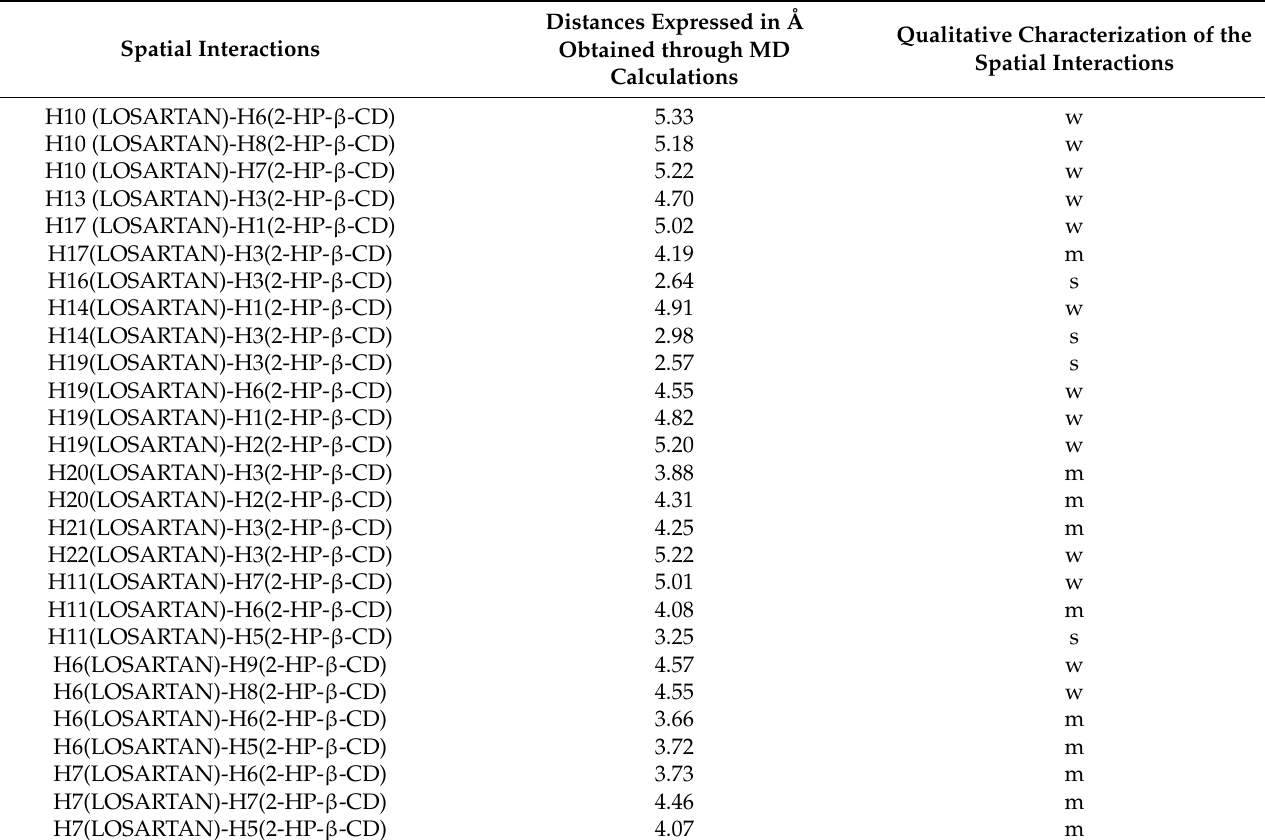
Table 3. The most important comparative distances in the complex obtained through 2D ROESY and DFT MD